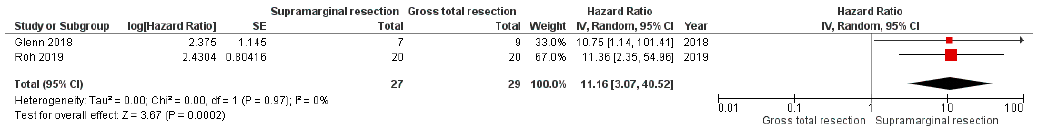
Figure 2. Forest plot displaying log (hazard ratio), HR, and 95% CI estimates for PFS in studies [24,28] evaluating SMR compared to GTR in GB patients. X-axis locations of squares represent the hazard ratio; the bigger the square, the greater the weight due to sample size. The diamond corresponds to the hazard ratio of the overall data.